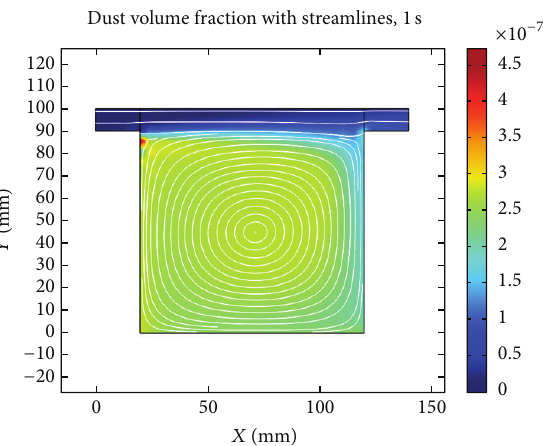
Figure 8: Dust initial volume fraction.